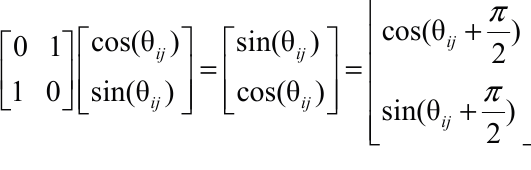
Algorithm 1. Quantum Wind Driven Optimization (QWDO) Algorithm.